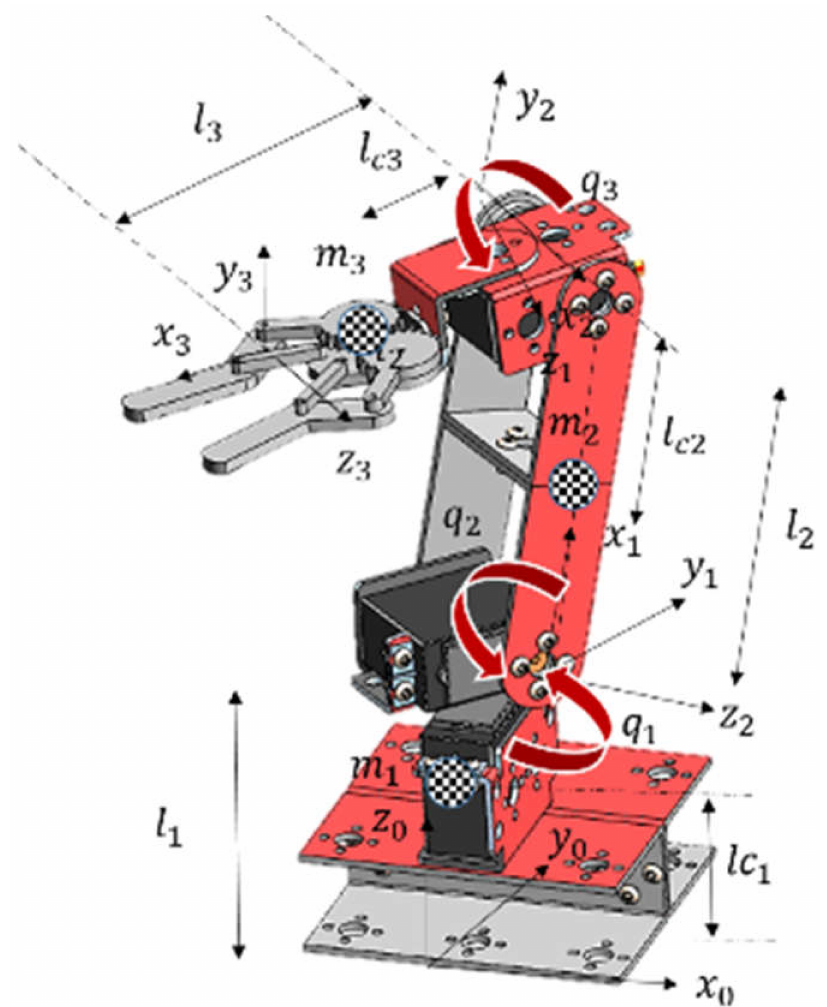
Figure 15. Virtual model of an anthropomorphic robot with three degrees of